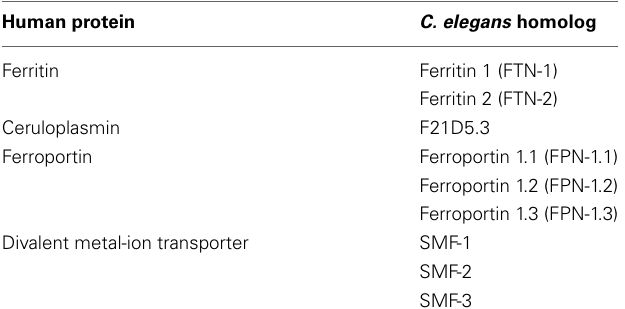
Table 3 | C. elegans iron metal homeostasis proteins. Human protein C. elegans